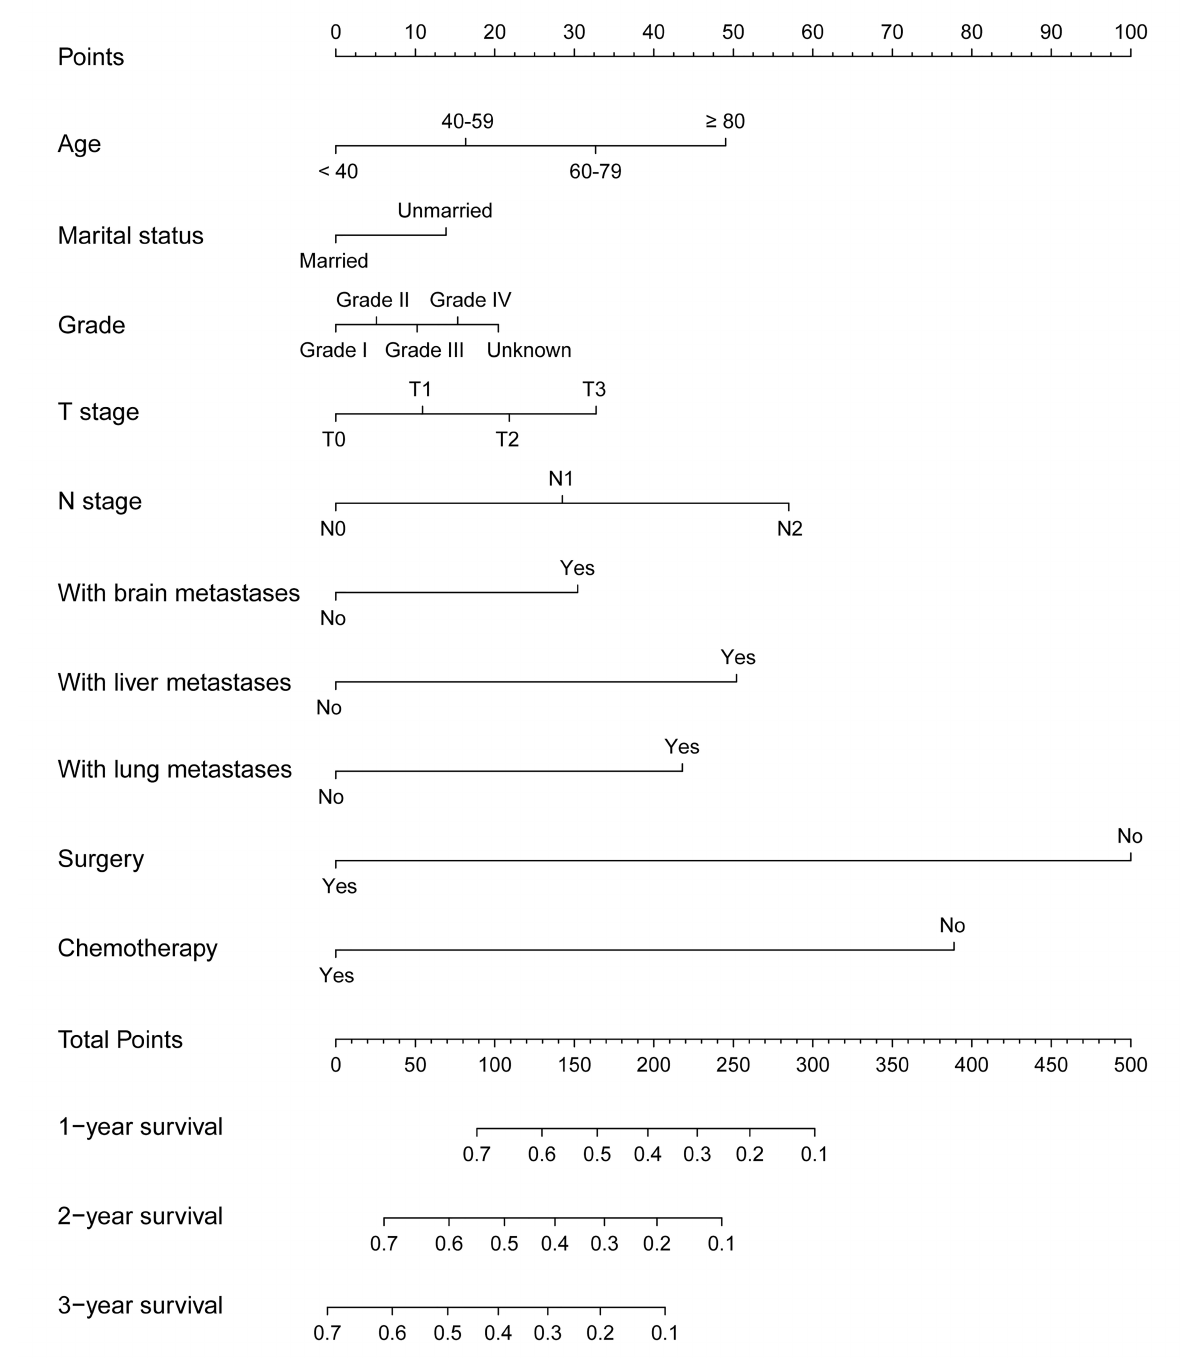
Figure 2 - The 1-, 2-, and 3-year nomogram model for overall survival (OS) for patients with bone metastatic renal cell carcinoma